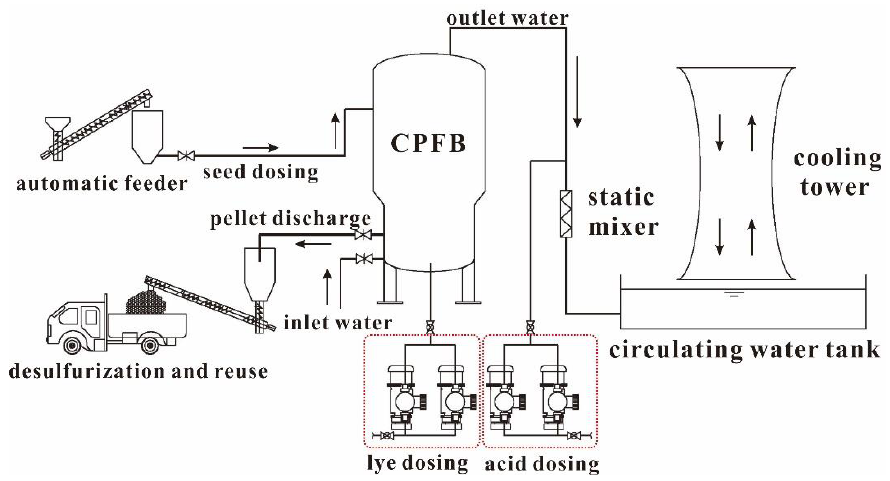
Figure 1. Flow chart of the circulating pellet fluidized bed softening system.